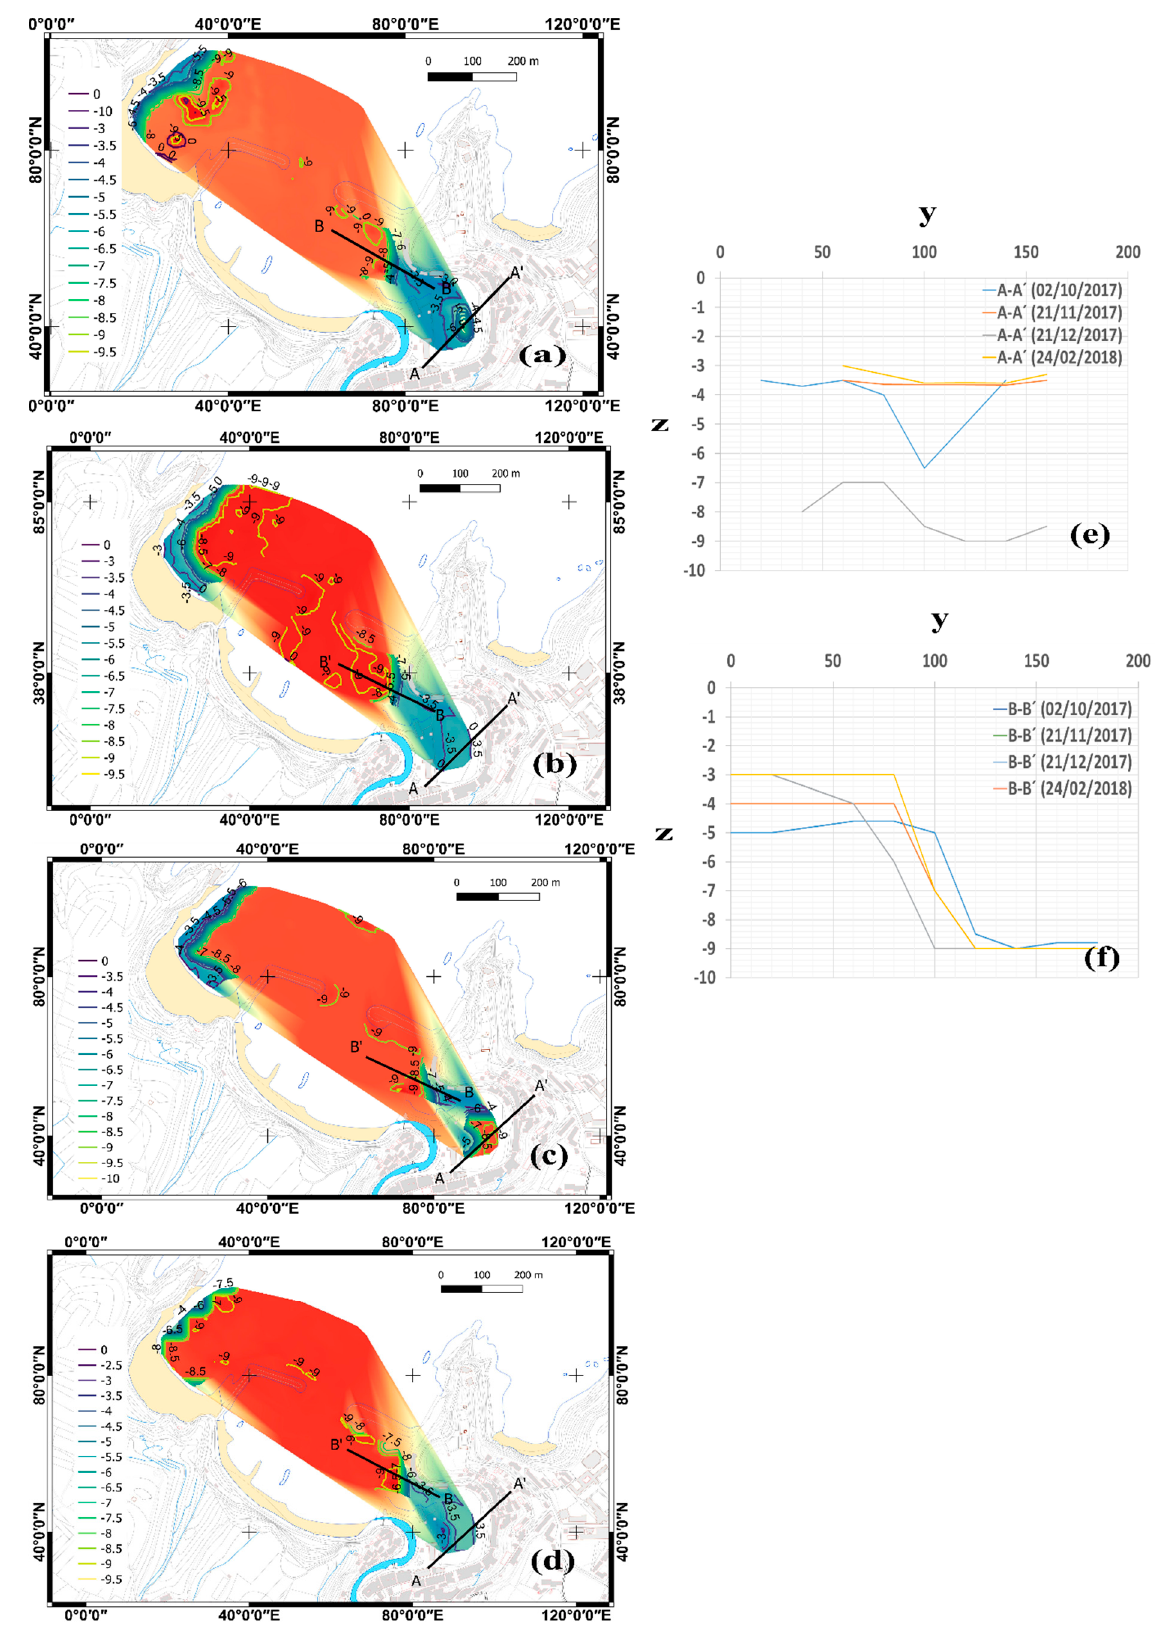
Figure 5. A representation of the behavior of the interior basin the dredging on: ( a ) 02/10/17, ( b ) 21/11/17, ( c ) 21/12/17 and ( d ) 24/02/18; and cross-sectional profile ( e ) AA’ of the inner dock, and ( f ) BB’ of the inlet channel.